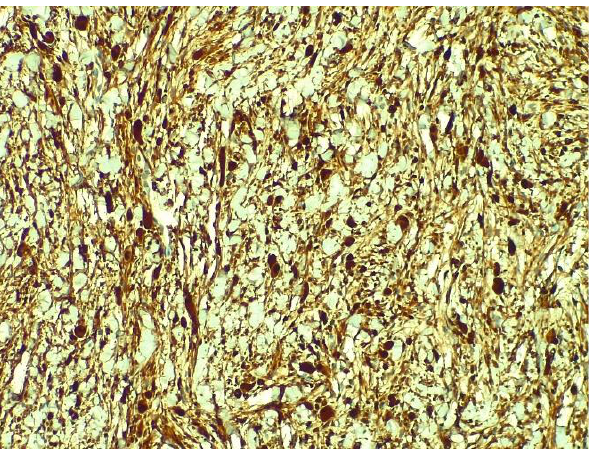
Figure 6. Immunohistochemical examination showing S100 marker diffusely positive in the fusiform cells .